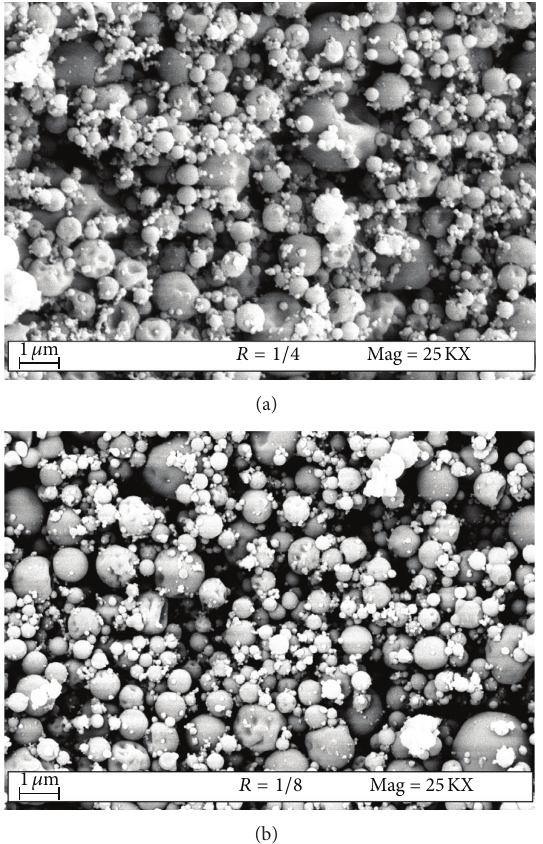
Figure 4: FESEM images of dexamethasone-PVP microparticles, with 𝑅 = 1/4 and 𝑅 = 1/8 , obtained by SAA operated at 40 ∘ C and 76 bar in the saturator and 70 ∘ C and 1.6 bar in the